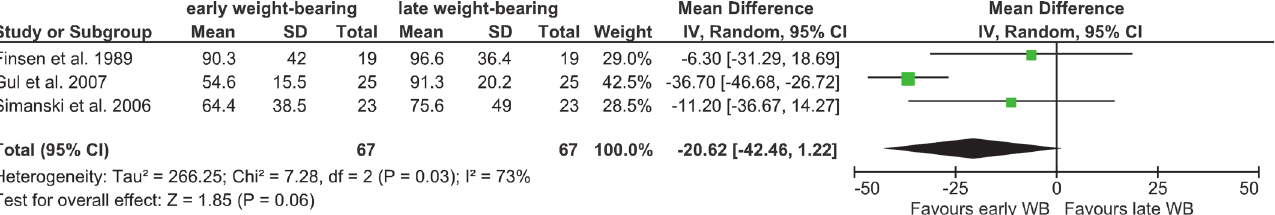
PLOS ONE | DOI:10.1371/journal.pone.0118320 February 19,